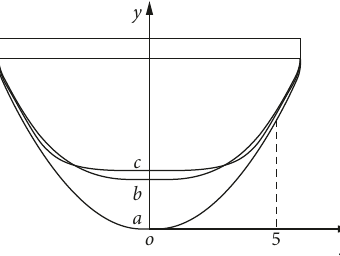
Figure 3: Schematic diagram of curve: (a) mixed curve, (b) power curve, and (c) index curve.